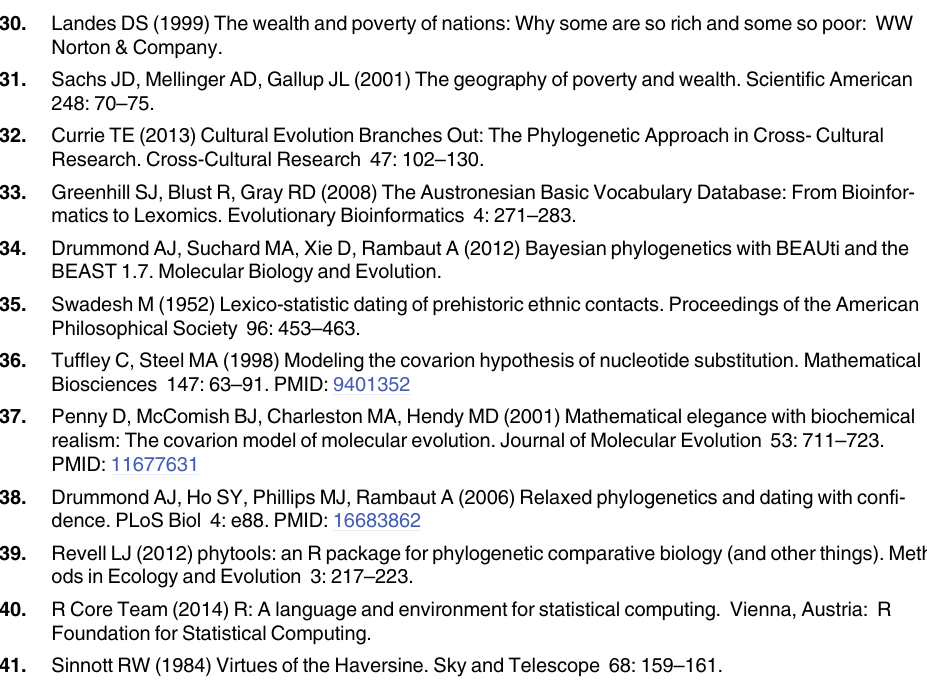
PLOS ONE | DOI:10.1371/journal.pone.0156340 May 27,